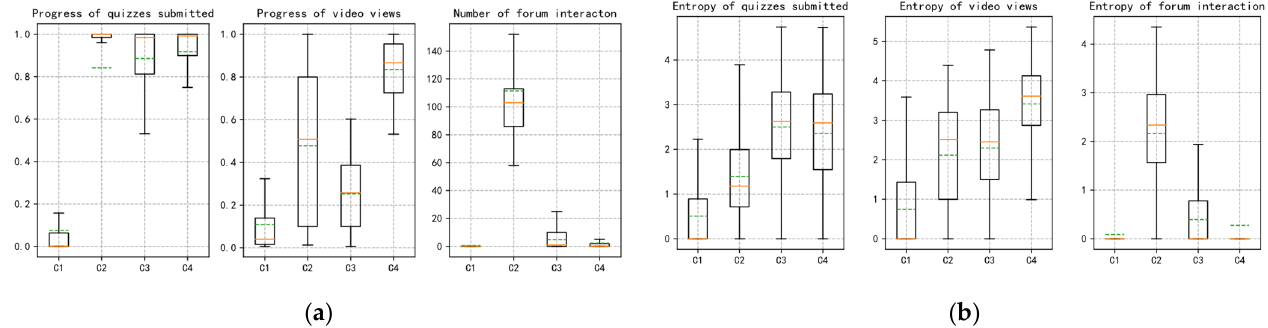
Figure 4. ( a ) The data distribution of the three main behavioral indicators (the left three subfigures), which represent the data distribution of quizzes submission, video viewing, and forum interaction of learners, respectively; and ( b ) the data distribution of three corresponding behavior entropies (the right three subfigures). Notes: the solid orange line represents the median and the dotted green line represents the average